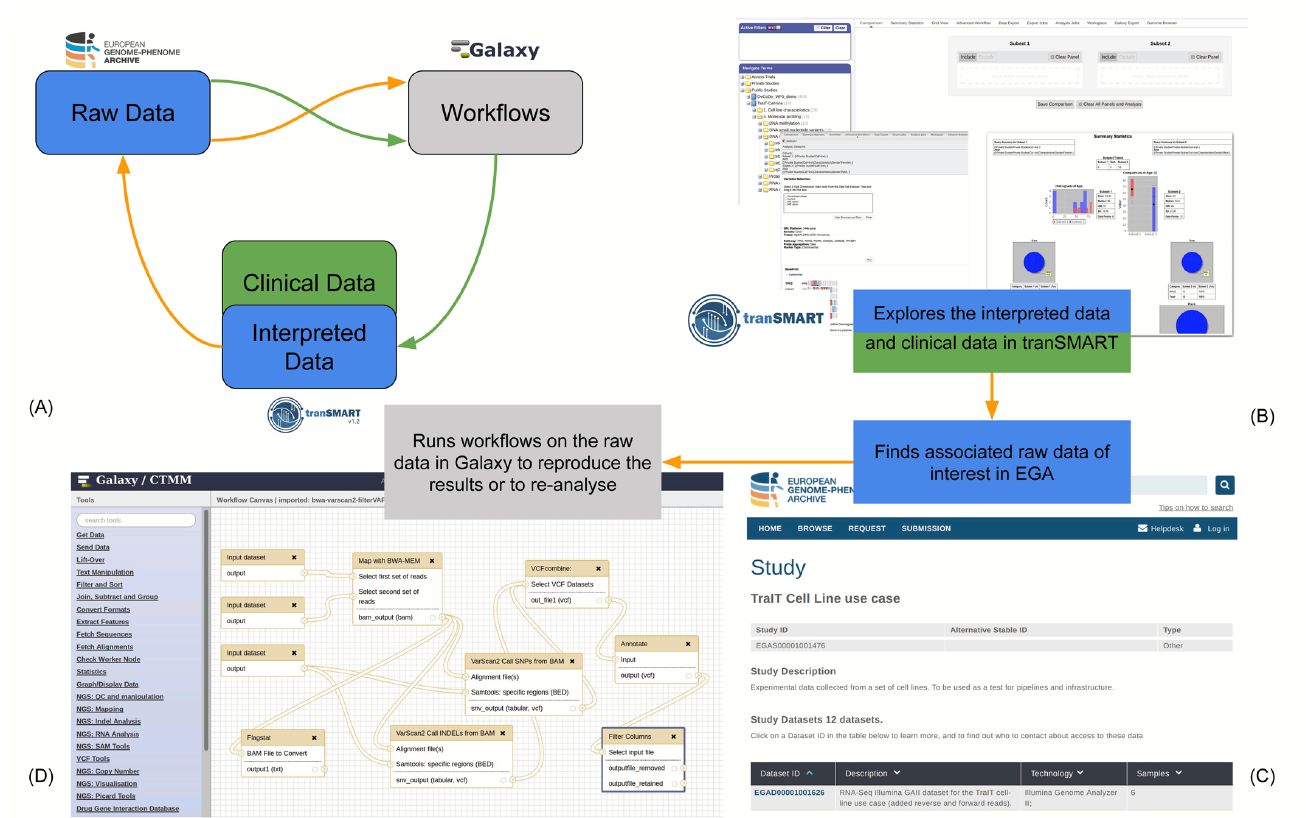
Figure 1. The usage scenario considered in the implementation study. A : The process for data generation (green lines) is different from that for data reuse (orange lines). B – D : Intended scenario of reusing data for translational research: first, the samples of interest can be discovered by exploring the clinical and interpreted data in tranSMART (v16.1); note that it is essential to present enough metadata for effective exploration ( B ); next, the raw data in EGA can be traced back from the interpreted data in tranSMART ( C ); finally, workflows can be re-applied to the raw data in Galaxy ( D